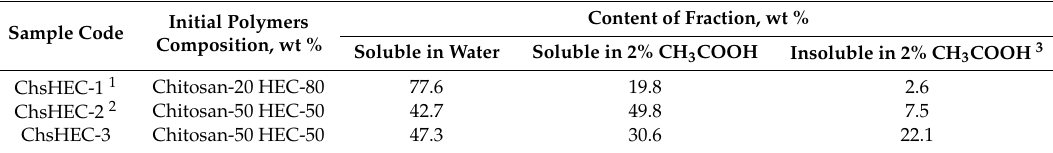
Table 1. Solubility of the samples in various aqueous